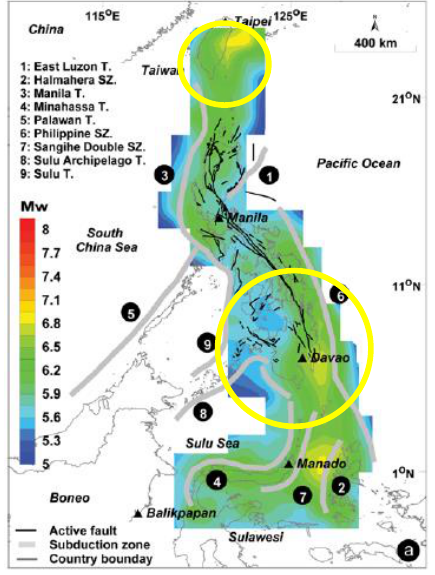
Figure 17. Maximum Earthquake Magnitude likely to be generated within 5